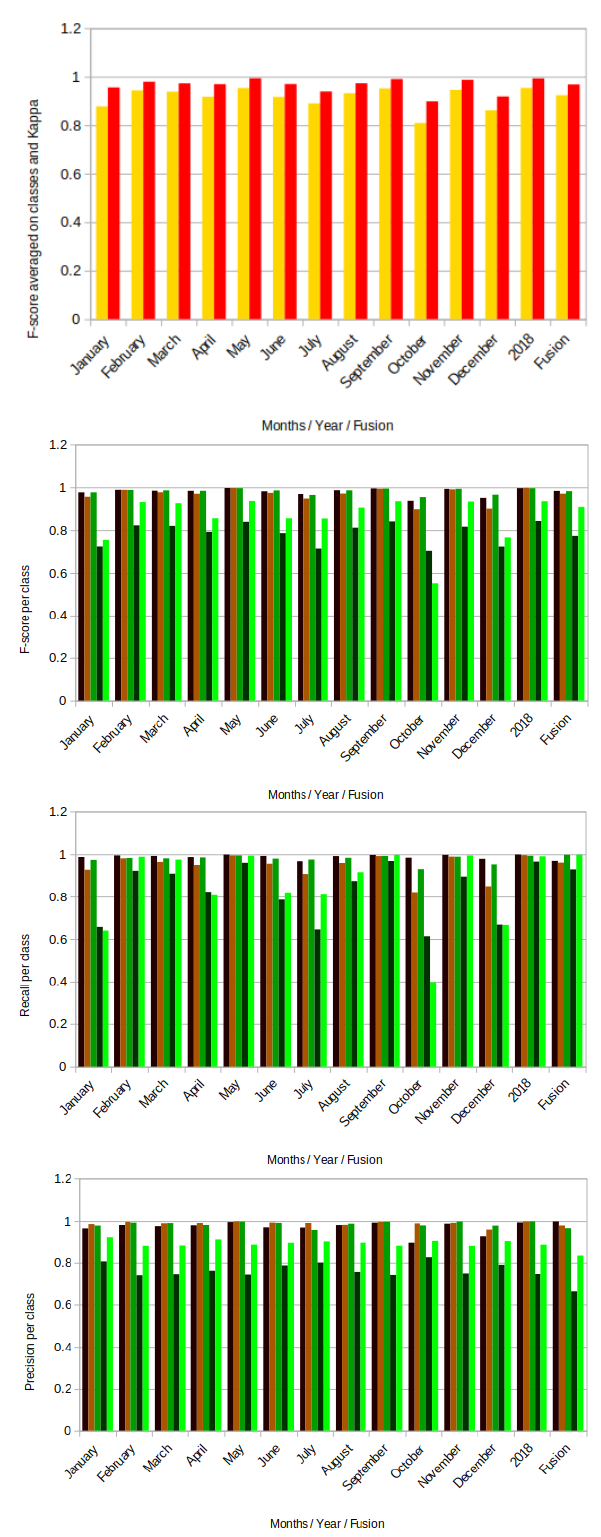
Figure 4. Global (F-Score averaged on vegetation classes (cid:4) and Kappa (cid:4) ) and per vegetation class (F-Score, recall and precision) quality metrics for the study area for months and year and for fusion of monthly classifications. (cid:4) : TS; (cid:4) : SS; (cid:4) : CA; (cid:4) : CAT; (cid:4) :